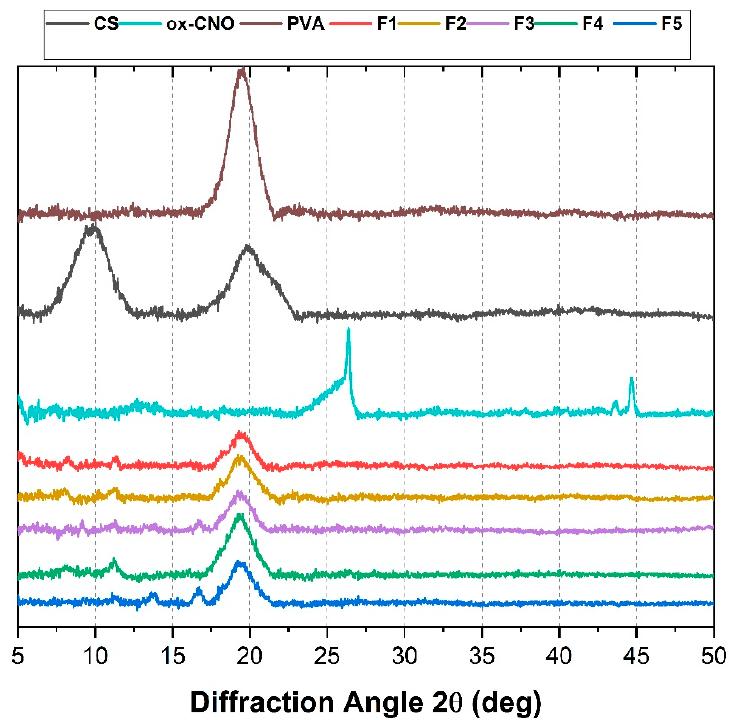
ff raction (XRD) of CS / PVA / ox-CNO films. Formulations: F1 (CS: Figure 3. X-ray diffraction (XRD) of CS/PVA/ox-CNO films. Formulations: F1 (CS: PVA:ox-CNO Figure 3. X-ray di